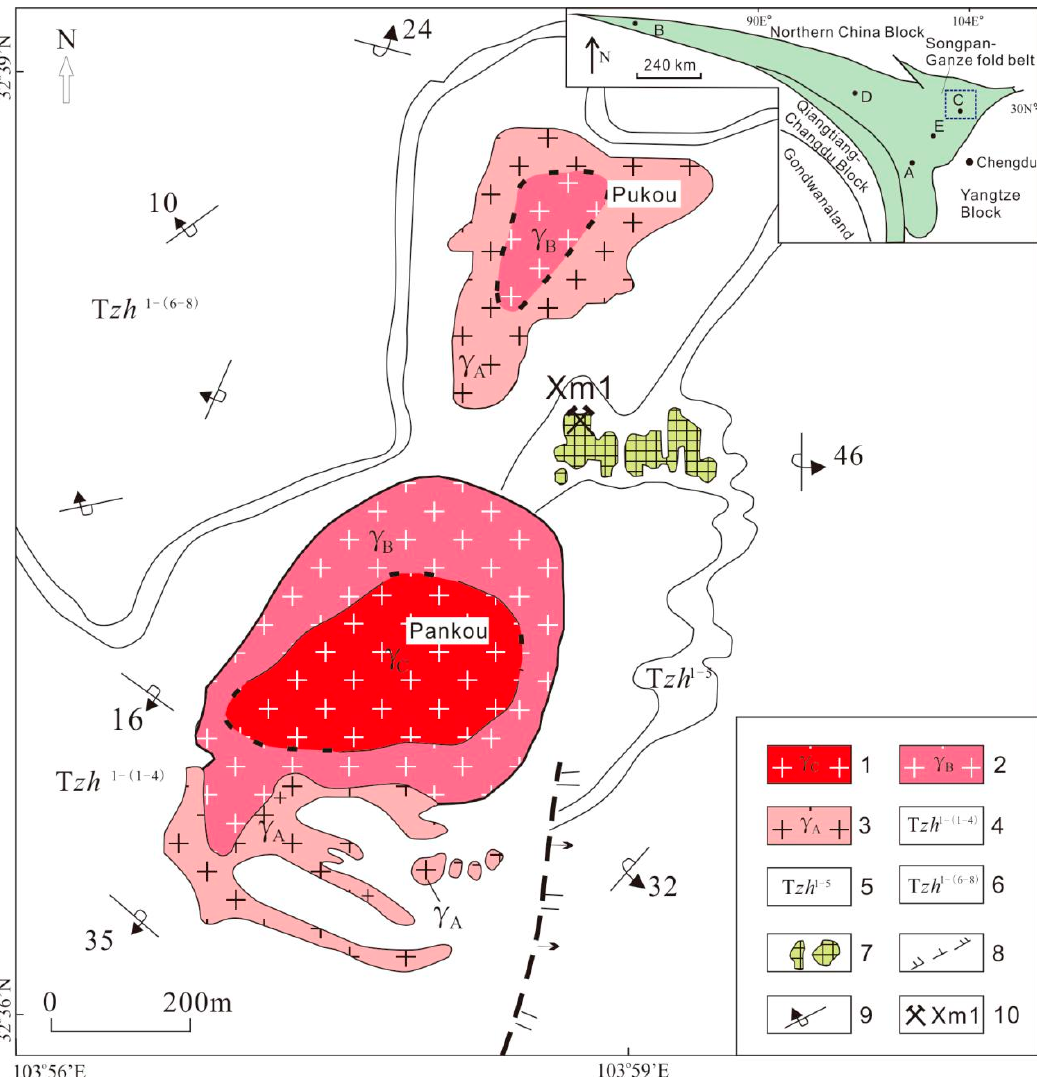
Figure 4. Geological map of the Xuebaoding granitic pegmatite W–Sn deposit, Sichuan Province, China. 1: Marginal zone of granite; 2: Middle zone of granite; 3: Core zone of granite; 4: Quartz schist, marble, and biotite quartz schist of the Triassic Zhuwo Formation; 5: Marble-bearing mineralization pegmatite dikes of the Triassic Zhuwo Formation; 6: Calcium quartz schist and sericite–quartz schist of the Triassic Zhuwo Formation; 7: Area of mineralization pegmatite dikes; 8: Inferred fault; 9: Attitude of strata; 10: Muscovite sampling location with sample number in Table 1. The legend for the diagram in the upper right-hand corner is provided in Figure 1.